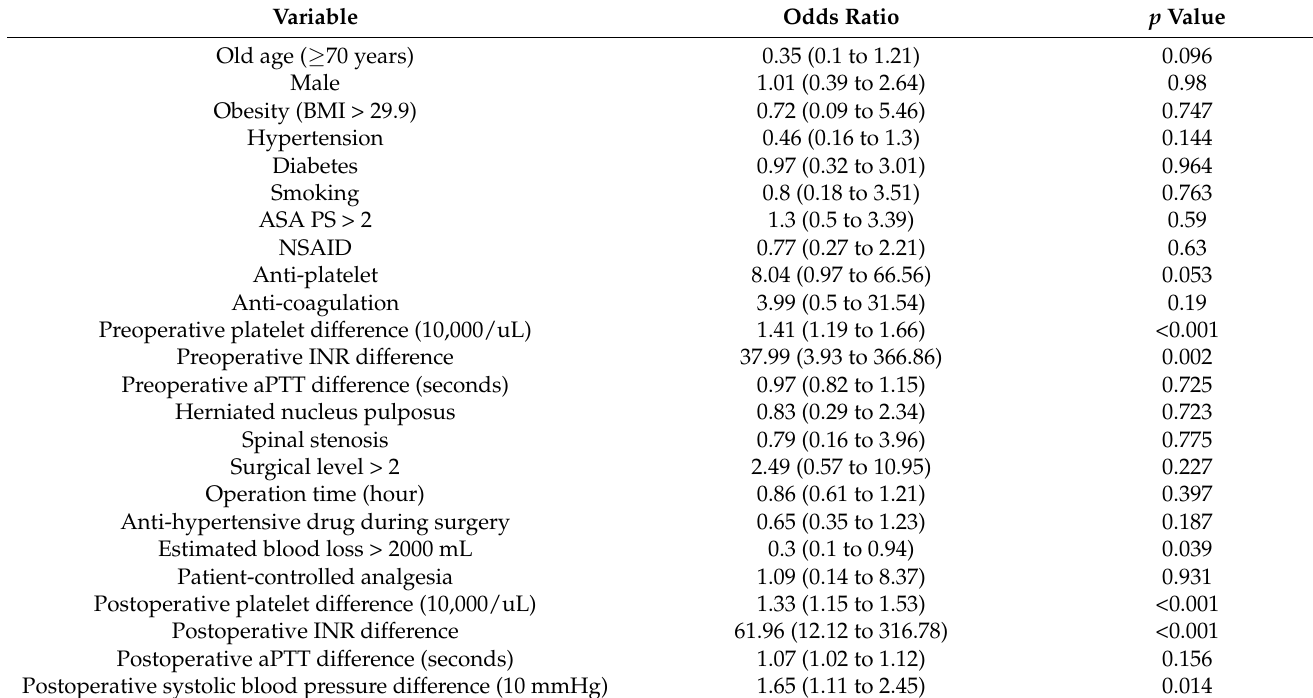
Table 2. Unadjusted odds ratio for postoperative symptomatic lumbar epidural hematoma.